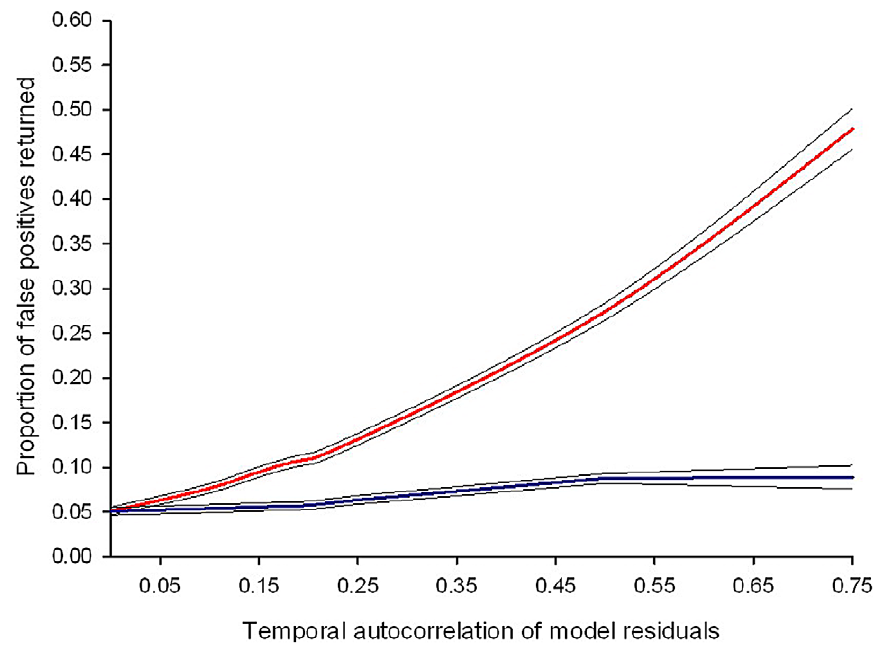
Figure 2. Failing to control for temporal auto-correlation increases type 1 error rates. Simulated data sets with known levels of temporal auto-correlation between residuals (spanning the range observed in published data sets) were generated using R version 2.12.1 (The R Foundation for Statistical Computing; http://www.R-project.org). Auto-correlation is highest between consecutive days and reduces as the duration between data points increases (auto-regressive error structure). The simulated data sets were designed so that any difference in treatment groups was due to chance: if the linear mixed effects model performs correctly it should, by definition, return a p -value of # 0.05, 5% of the time. The red line represents the proportion of false positive results (where a statistically significant difference between treatment groups is wrongly concluded) from linear mixed effects models. The blue line shows the proportion of false positive results if an auto-regressive error structure is included in the model. Values are averaged from a minimum of 10,000 simulated data sets and the black lines show the 95% confidence intervals around the mean.